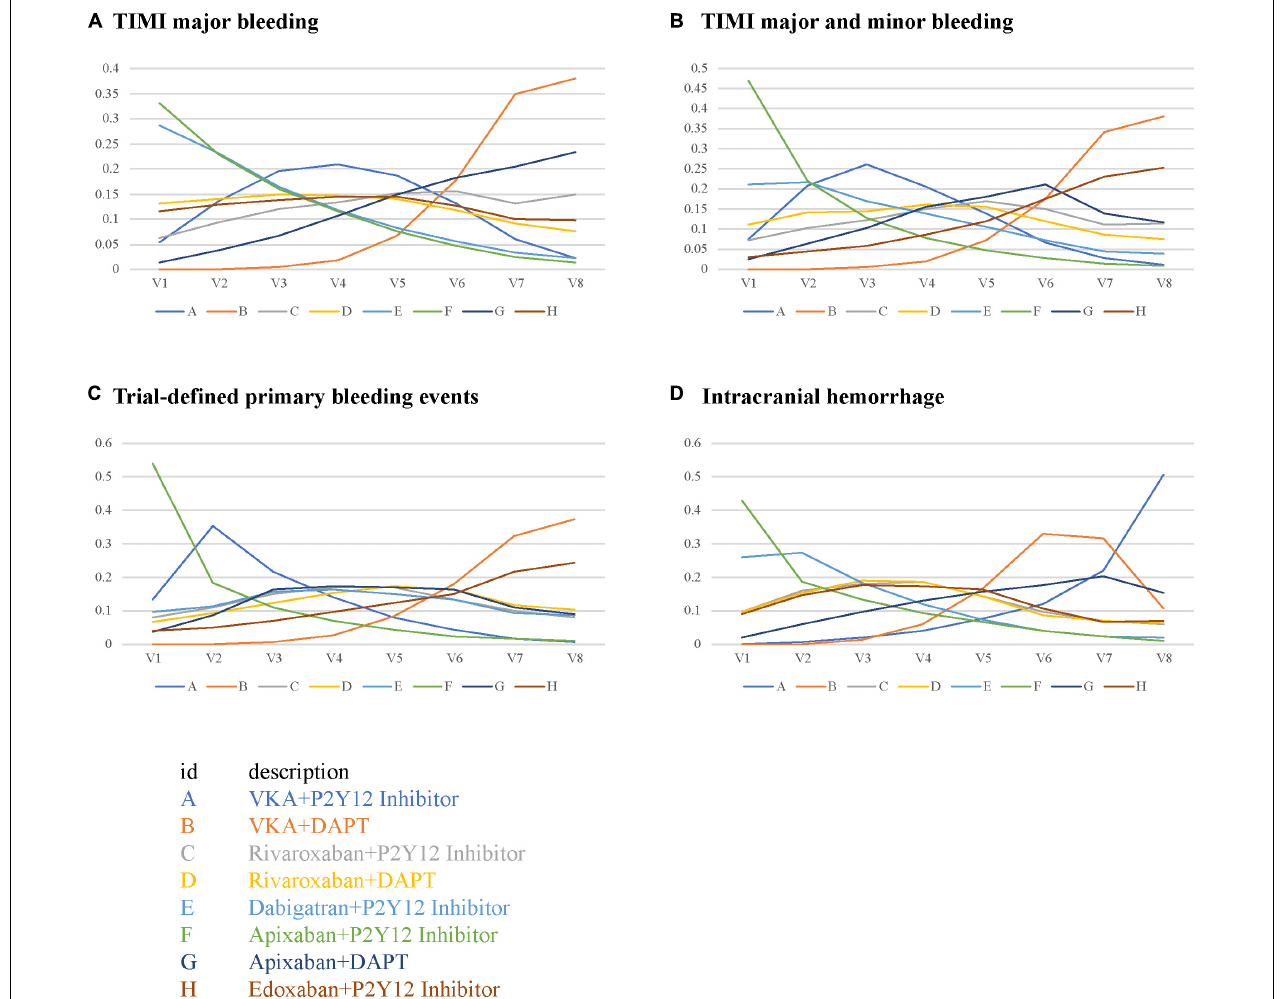
FIGURE 6 | Rank probabilities for safety outcomes. (A) TIMI major bleeding. (B) TIMI major and minor bleeding. (C) Trial-defined primary bleeding events. (D) Intracranial